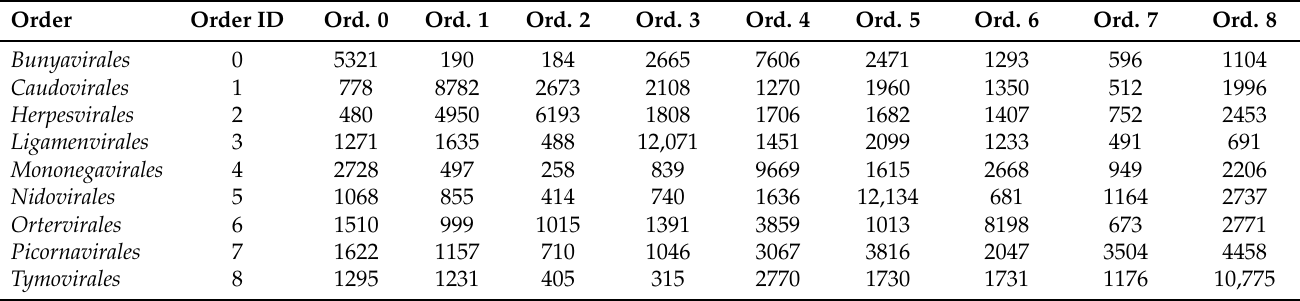
Figure 3. Accuracy performance history. The performance history of four exemplarily chosen simulation runs is depicted. The smoothness of the curves could be reached by a large batch size. The training time varies vastly, exceeding 500 epochs on plot ( A ) and falling below 50 on plot ( D ). Whilst training loss decreases subject to exponential decay, training accuracy increase is logarithmic. Validation accuracy exceeds simple random classification probability of 11% considerably. Plot ( A ) holds a remarkable behaviour of validation performance. From epoch 150 on, validation loss and accuracy both increase simultaneously. This portends that predictions of class probabilities incline to become increasingly imprecise, whereas classification results are increasing in accuracy. In contrast to plot ( A ), on plots ( B – D ) loss and accuracy performance on validation data are superior to that in training data. Table 4. Average confusion matrix. Confusion matrix showing classification results for 21,429 simulated viral reads, where rows represent the true biological order and columns represent order predicted by the artificial neural network. Results are averaged over 10 simulation runs. Reads on the diagonal were correctly classified, while correct classification rates are higher than those of a random classifier, still a large number of misclassifications